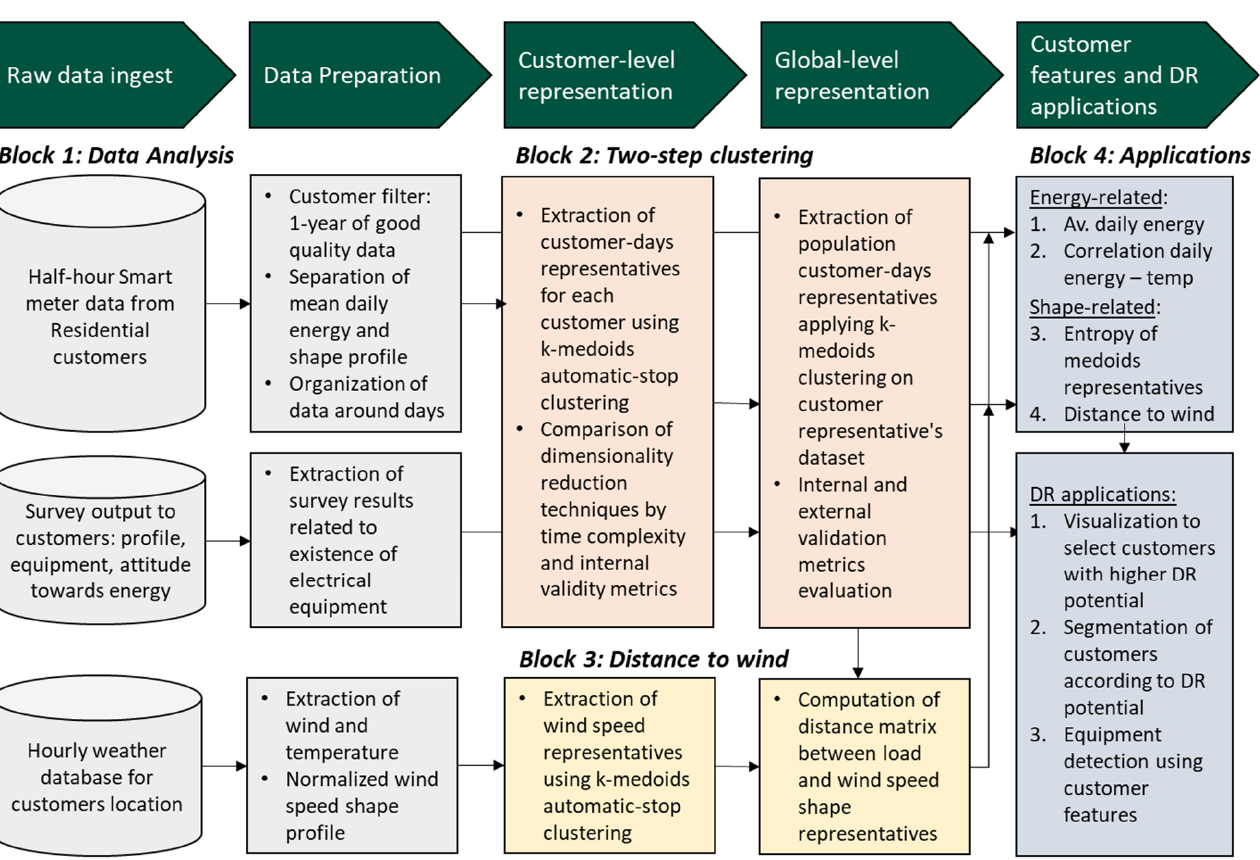
Figure 1. Smart meters time series clustering for DR applications methodology.